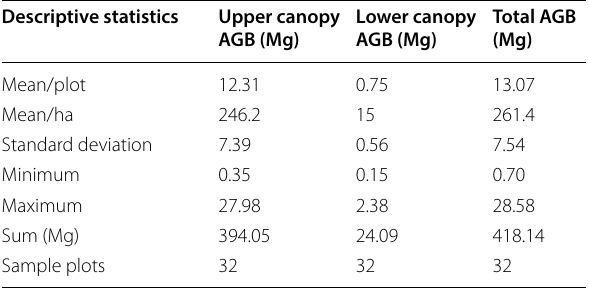
Table 5 Overall descriptive statistics of estimated AGB